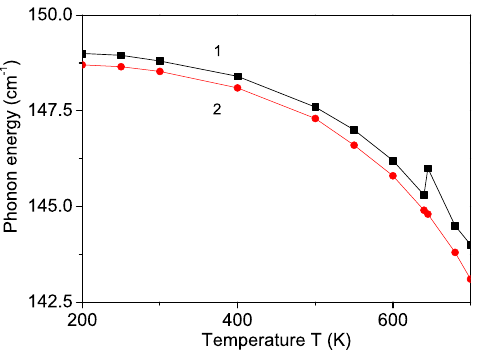
Figure 6. (Color online) Temperature dependence of the phonon mode ω = 149 cm − 1 in a YFO nanoparticle with N = 10 shells and different magnetic fields h : 0 (1); 50 kOe (2).